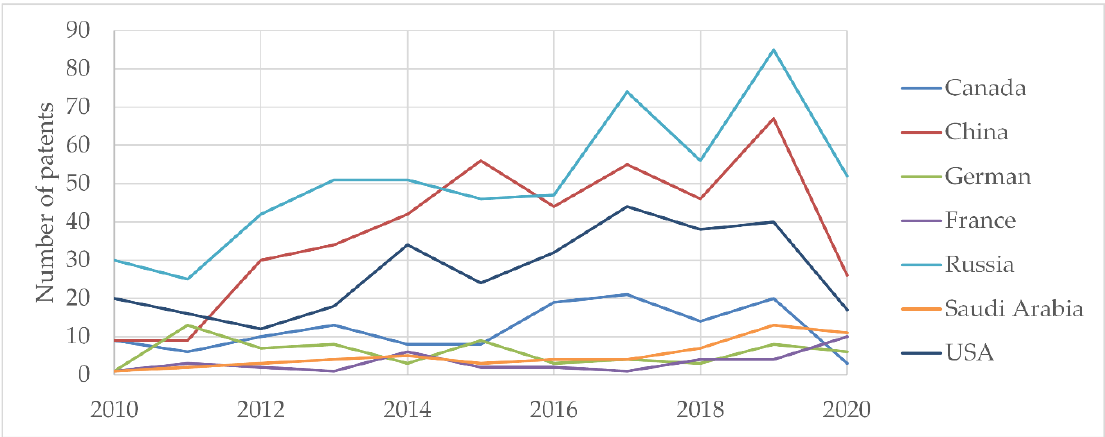
Figure 4. Dynamics of publication activity on enhanced oil recovery methods in key countries of the industry.